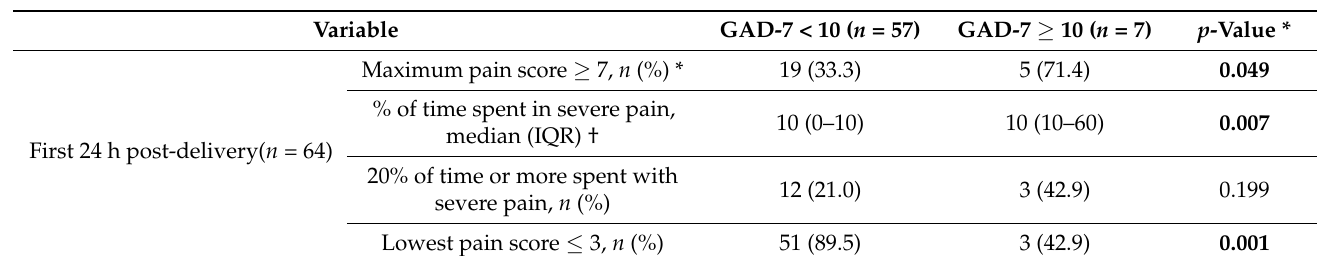
Table 3. Associations between pain and anxiety. Minimum, maximum pain scores in the first and second 24 h time period and for the whole hospitalization, and percentage of time spent in severe pain, per patient